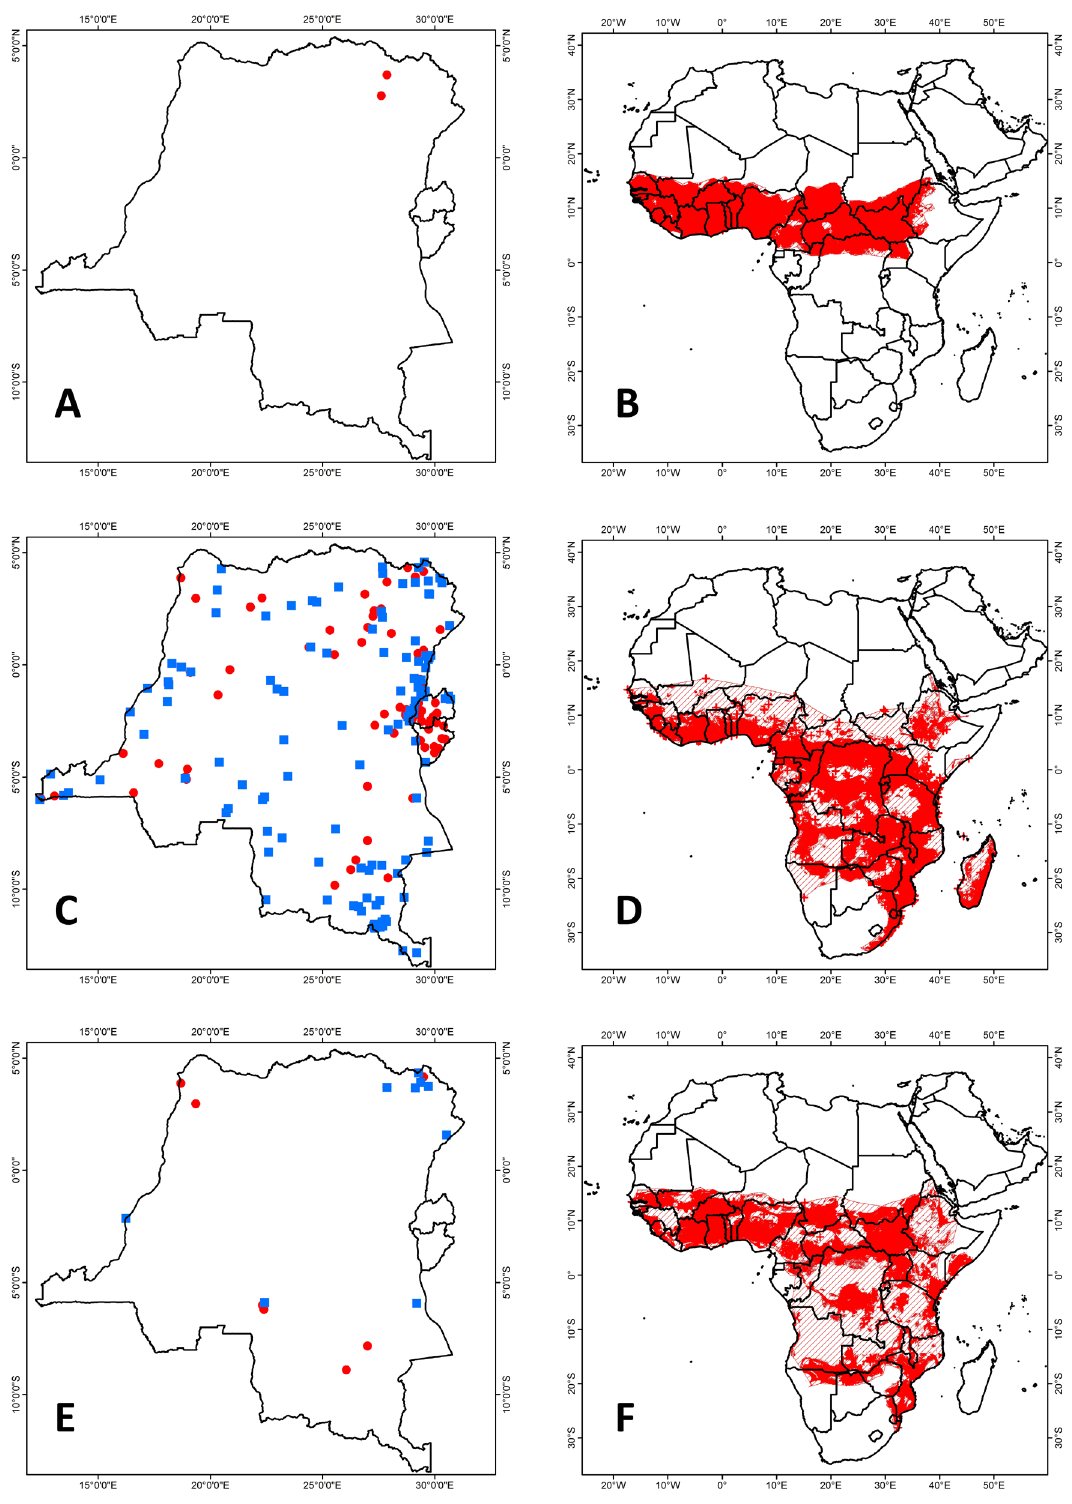
Fig. 44. Distribution maps. A–B . Neoromicia guineensis (Bocage, 1889). C–D . Neoromicia nana (Peters, 1852). E–F . Neoromicia rendalli (Thomas, 1889). A, C, E. Distribution in the CRB area. B,